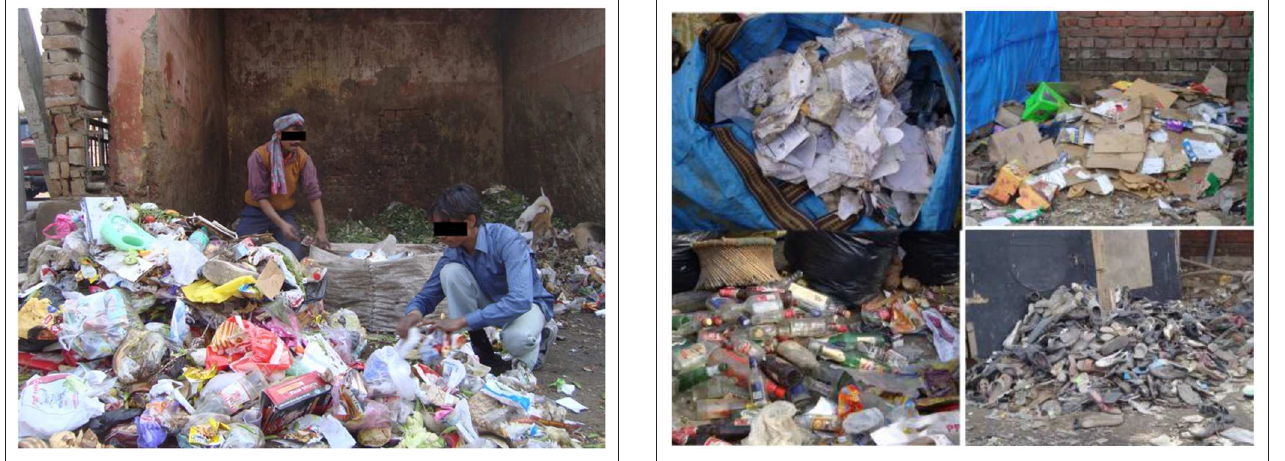
FIGURE 5 | At the khatta, waste is segregated and recyclables are collected.